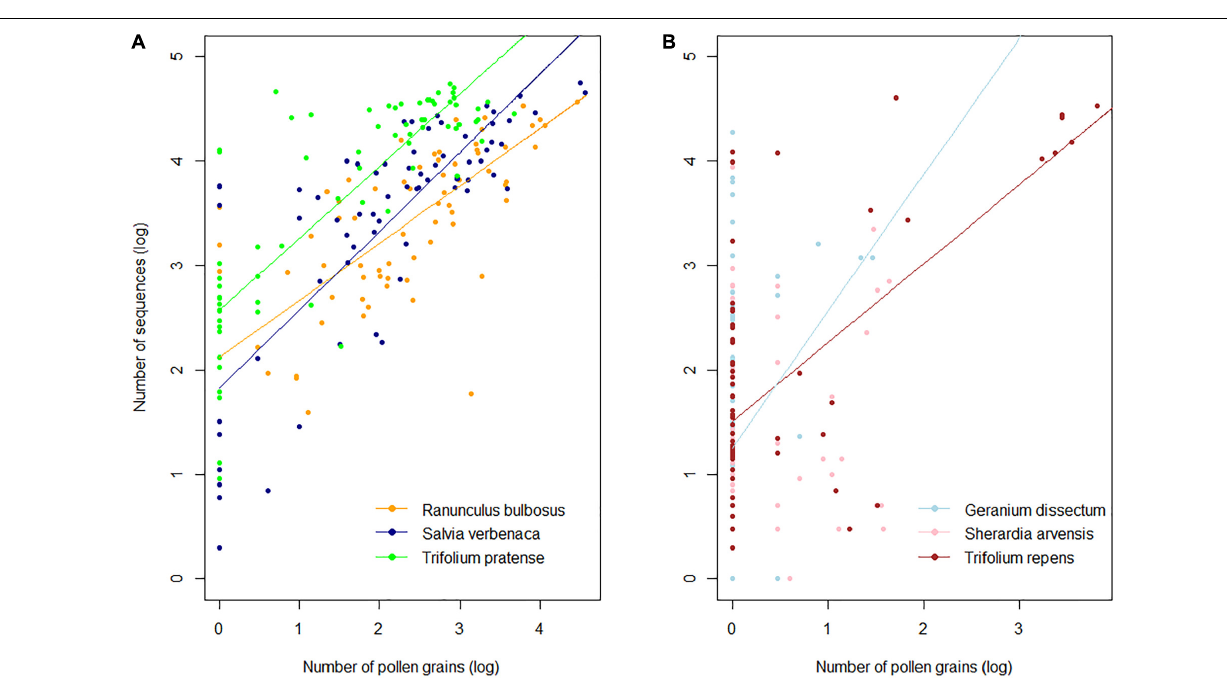
FIGURE 3 | Relationship between pollen abundance and sequence counts in (A) frequently visited (linear mixed model; see Supplementary Table 7 for model parameters) and (B) rarely visited plant species (non-parametric Kendall’s correlations). All values were log 10 transformed. also revealed a significant co-occurring pollen effect in species as no species effects ( p = 0.08) and no interactions were observed between co-occurring pollen abundance rarely visited species ( R 2 = 0.24; p = 0.02) with low positive and plant species ( p = 0.45) ( Supplementary Table 7 and ( G. dissectum : 0.31) and negative slopes ( S. arvensis : − 0.44; Figure 4A T. repens : − 0.62). The relationship was stable across these